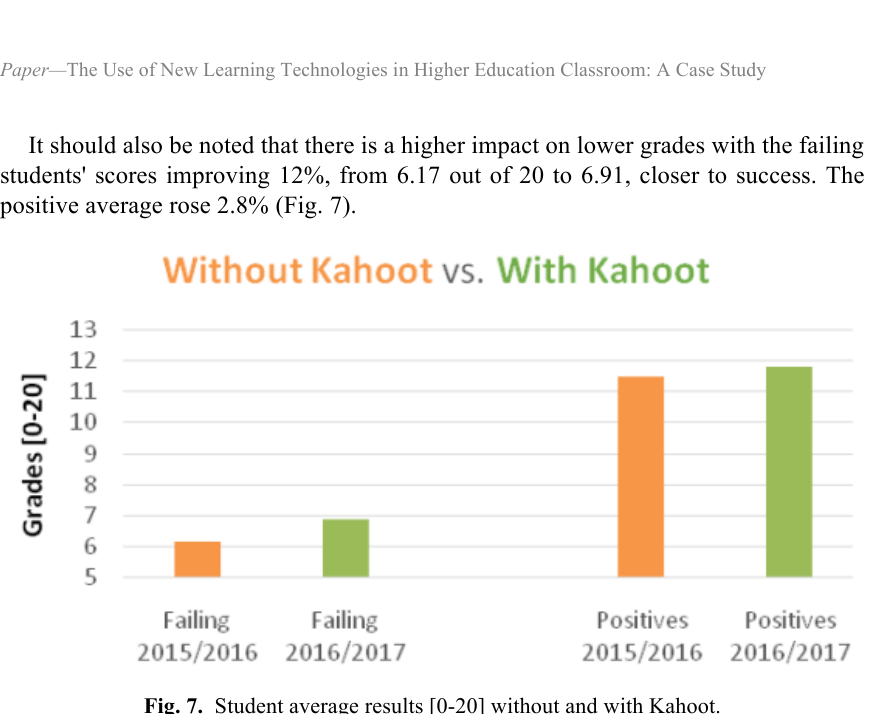
Fig. 7. Student average results [0-20] without and with